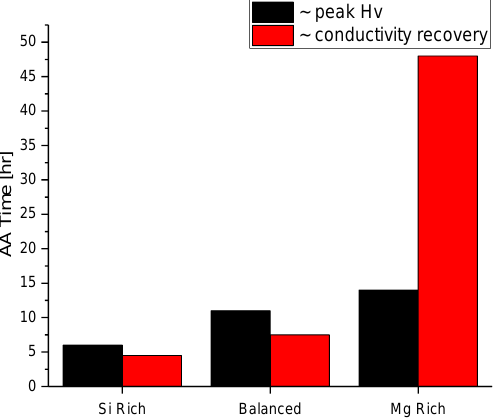
Figure 16. Comparison of AA times associated with peak hardness and conductivity recovery (of 4 h compared to 0.5 h prior NA conditions) for all of the water quenched, high strength alloys. Note that the peak Hv time does not necessarily indicate a hardness recovery (i.e., Mg-rich alloy). Error bars are not included because AA times were visually estimated based on aging curves.